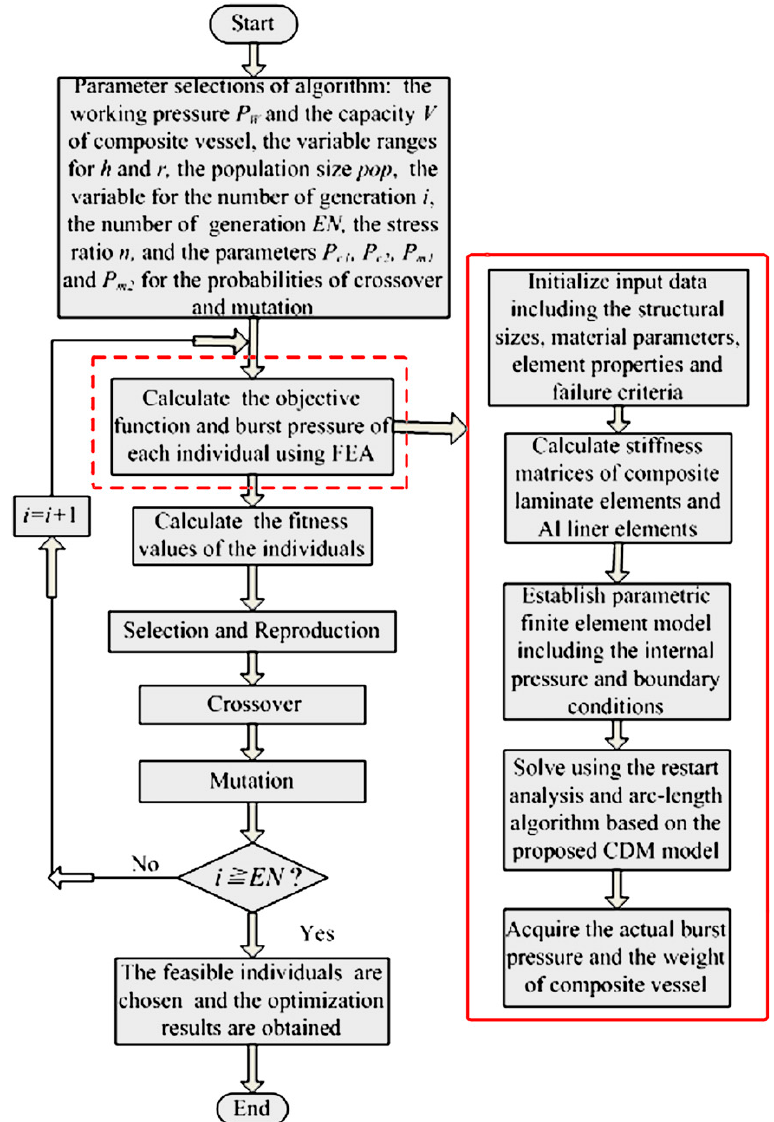
Figure 34. Flow chart of the adaptive genetic algorithm [116].